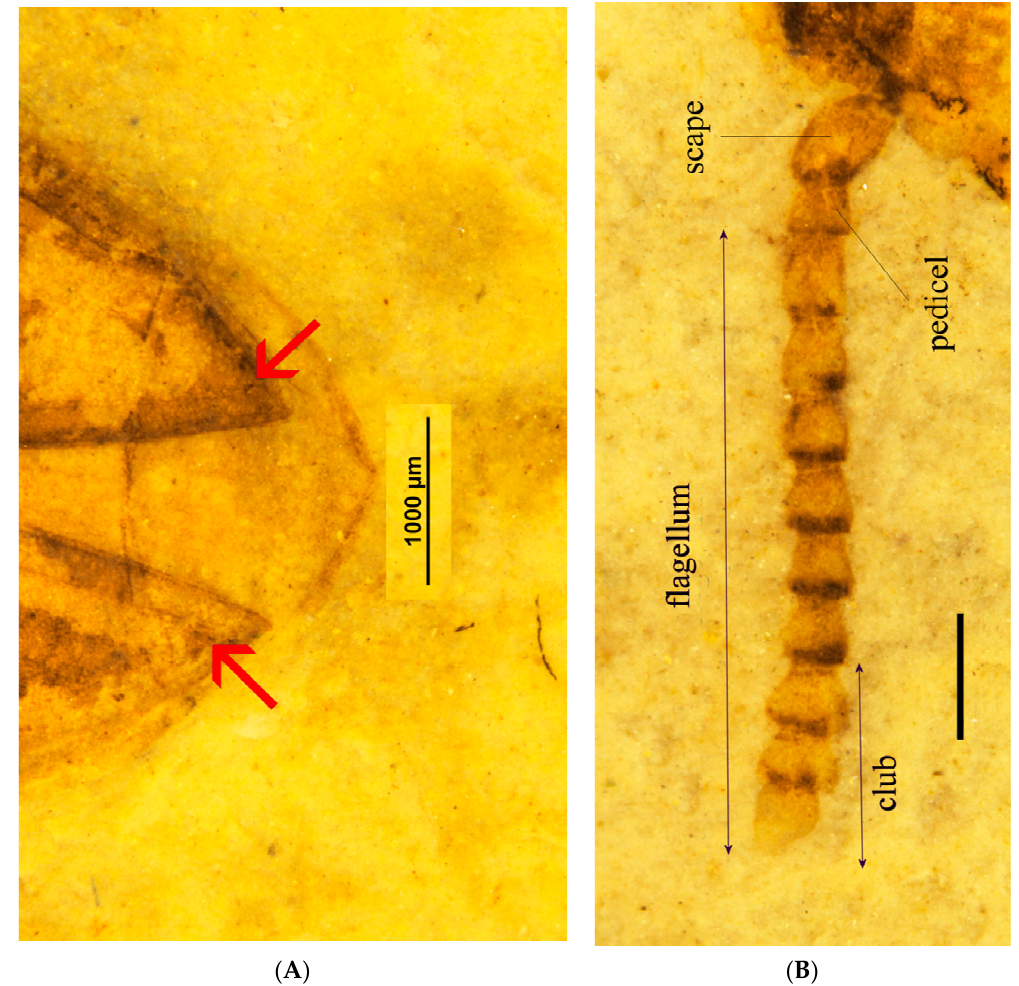
Figure 3. ( A ) Rheanischia brevicornis new species., holotype, elytral apices, arrows indicate excretory punctures; ( B ) paratype, antenna.